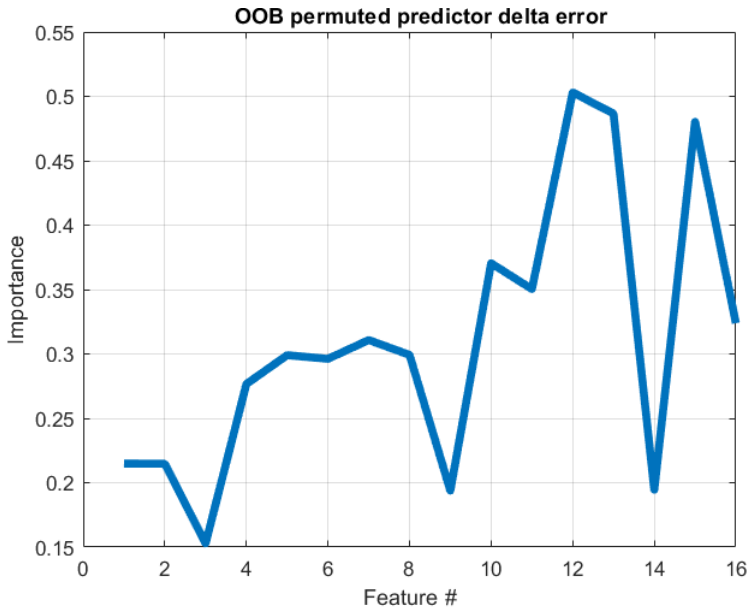
Figure 5. Feature importance using the random forest method. The plot represents the increase in prediction error for any given variable if the values of that variable are permuted across the out-of-bag observations. Therefore, the higher the induced error is, the higher is the importance of that variable; out-of-bag (OOB).